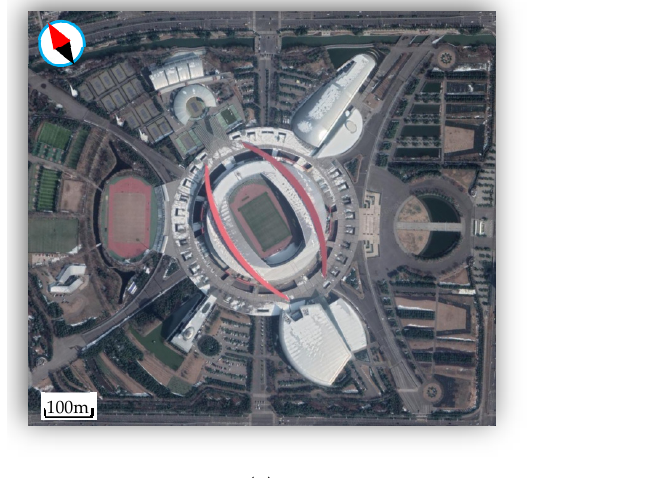
Figure 5. Five different types of road traffic signs and the ground control points on them (GCP1~GCP5): ( a ) hollow rectangle; ( b ) solid rectangle; ( c ) hollow diamond; ( d ) grid rectangle; ( e ) solid arrow.